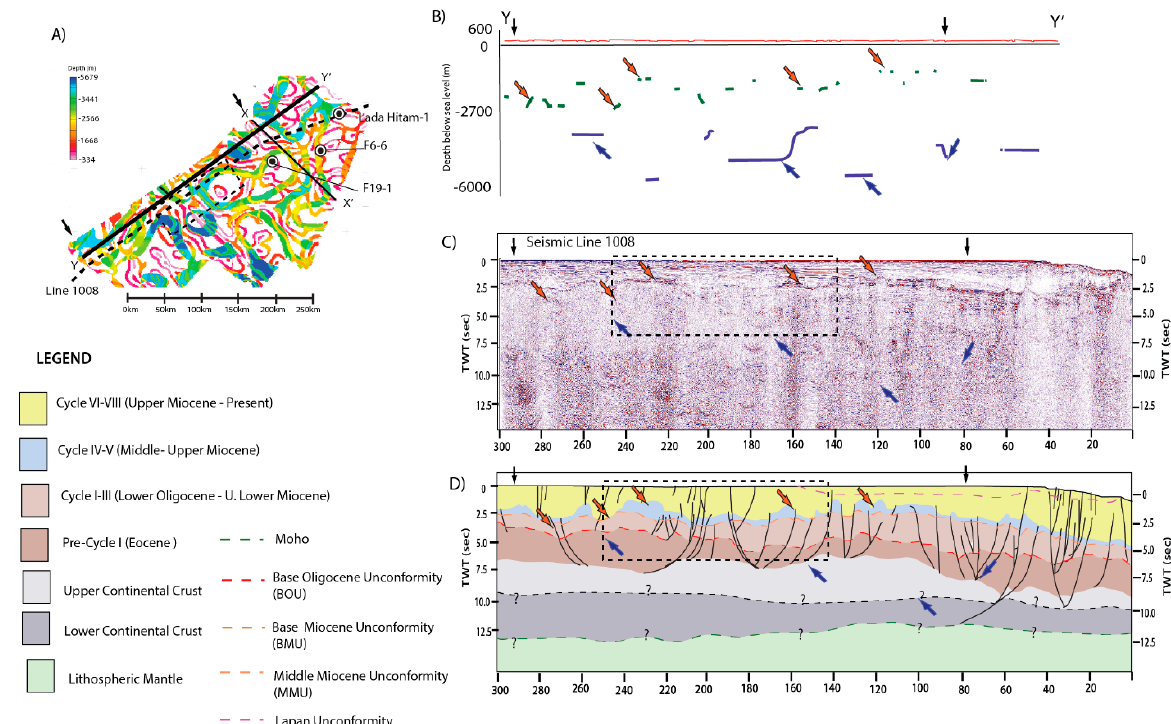
Figure 11. ( A ) Location of the depth profile X-X’ and seismic lines 1004 & 1014. ( B ) Depth profile X-X’ oriented in NW-SE. ( C , D ) Uninterpreted seismic sections for line 1004 and 1014 respectively. ( E , F ) Interpreted seismic for line 1004 and 1014, respectively. The blue and orange arrows are highlighting similar features pointed on the depth profiles and on seismic data. The seismic lines are marginally longer than the depth profile X-X’. The interception point for the depth profiles and seismic lines are pointed by black arrow at the top of images in ( B – F ).